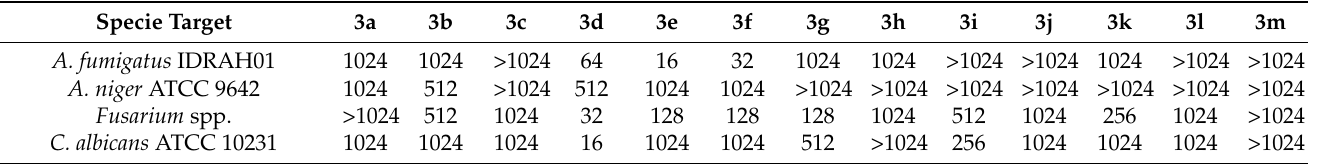
Table 4. Antifungal activity of sucrose-based compounds (MIC values are reported in µ g/mL). Specie Target